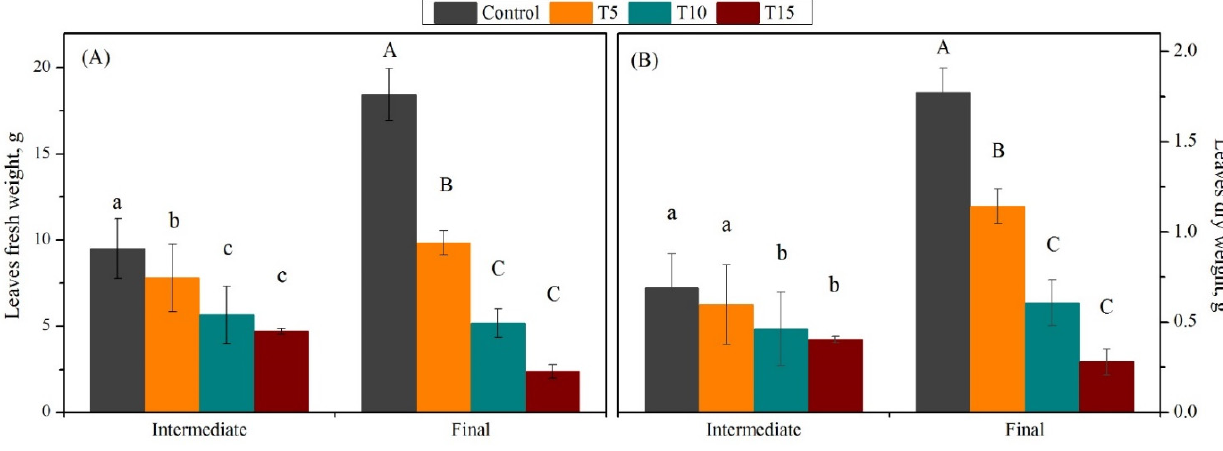
Figure 2. Leaves fresh weight ( A ) and leaves biomass ( B ) grown under the various salinity treatments at the intermediate and final harvests. Values are expressed as mean ± standard deviation ( n = 10). Different letters indicate statistically significant differences between treatments at each harvest (small letters refer to the intermediate and capital ones to the final harvest, p < 0.05).